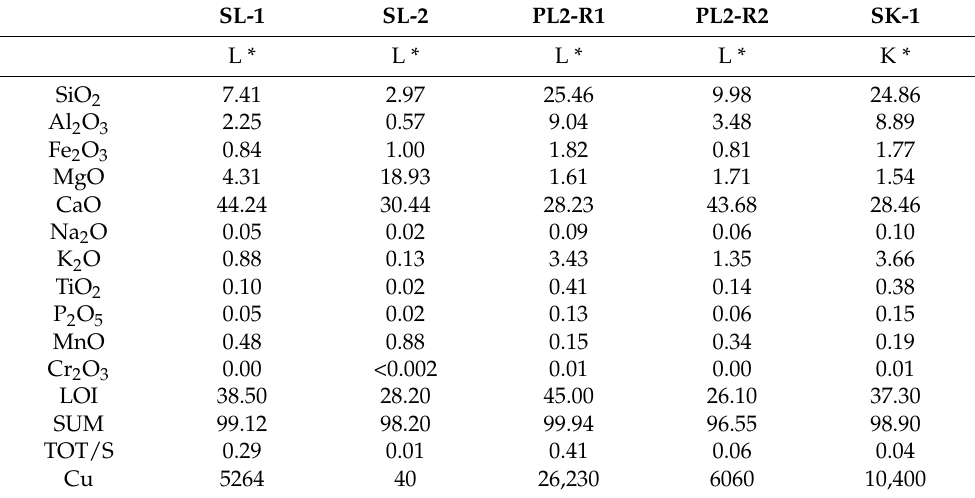
Table 6. Rock chemical composition. SL-1 SL-2